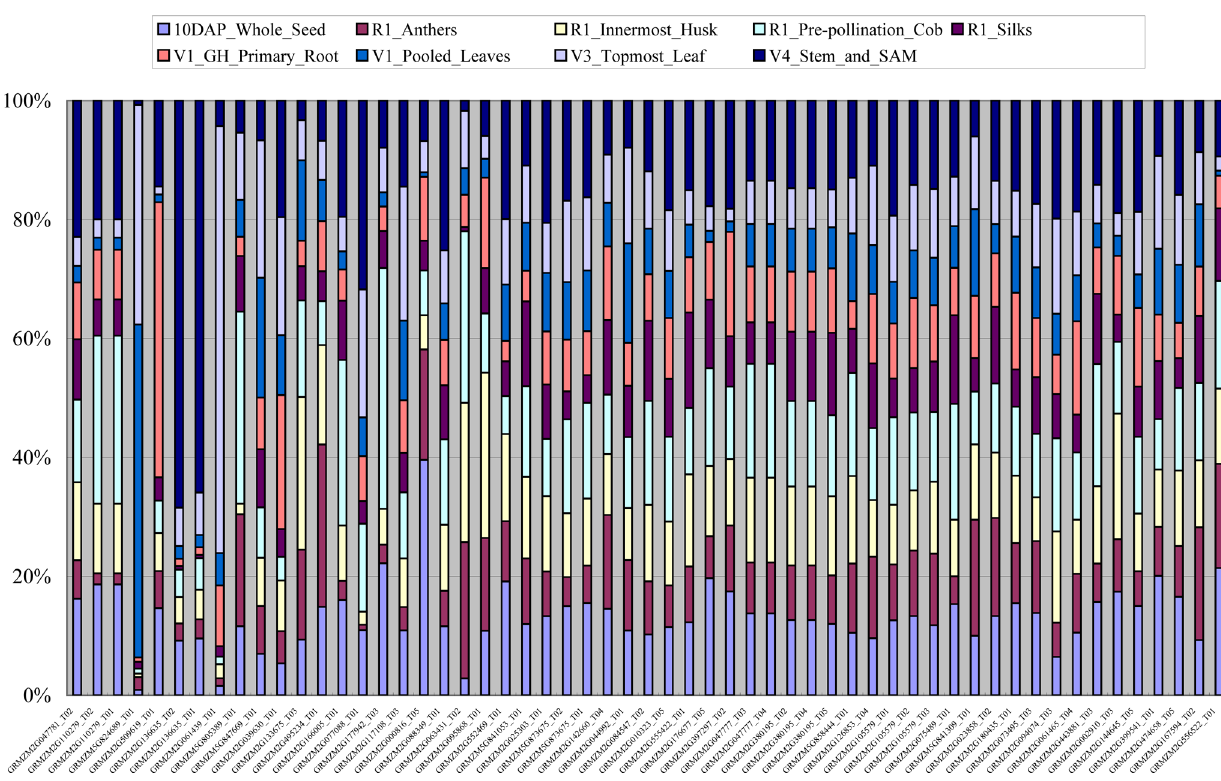
Figure 5. The tissue specific expression of 57 lncRNAs.